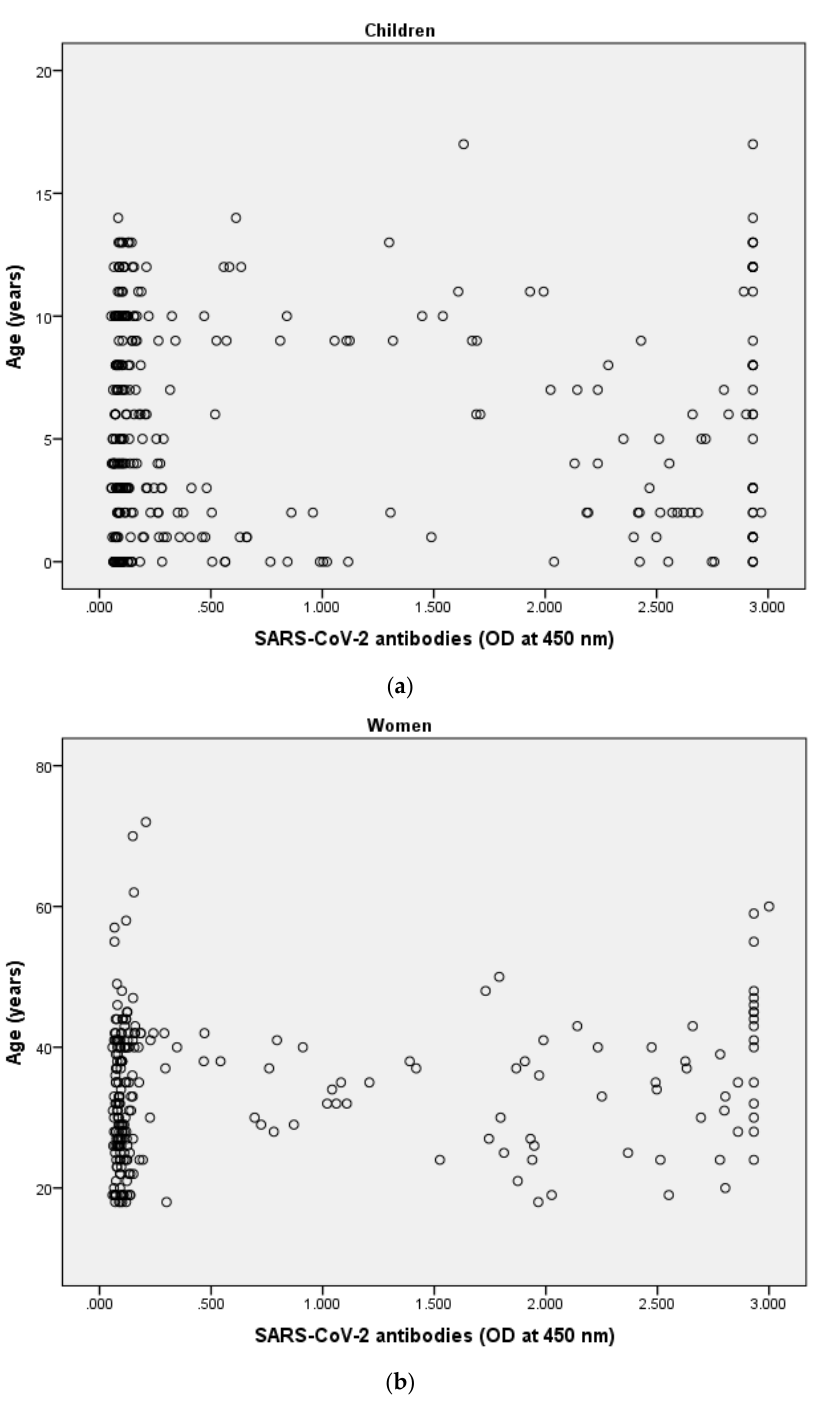
Figure 1. The result showed no correlation between antibody levels and age in children ( a ), r s = 0.01, p = 0.857). By contrast, a weak positive correlation was observed between anti ‐ S IgG antibody levels and age in women (r s = 0.19, p = 0.004, ( b )). Data obtained from the logistic regression analysis showed that higher women’s age increased the odds of SARS ‐ CoV ‐ 2 anti ‐ S IgG antibody status (odd ratio (OR) = 1.04; 95% confidence Interval = 1.02 to 1.07; p = 0.002). None of the other variables among women and children predicted SARS ‐ CoV ‐ 2 anti ‐ S IgG antibody status (Table 3).